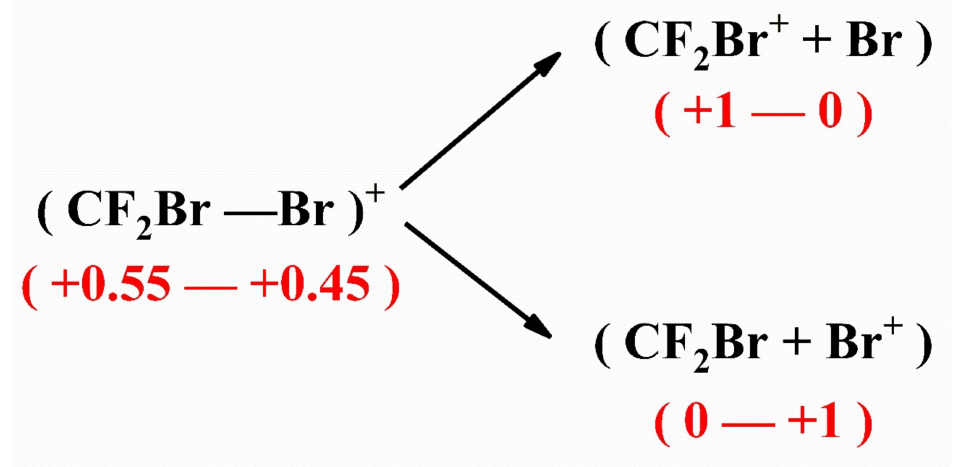
Figure 5. Natural bond orbital (NBO) charge distribution of CF 2 Br 2+ ions and the charge assignment of the corresponding dissociation